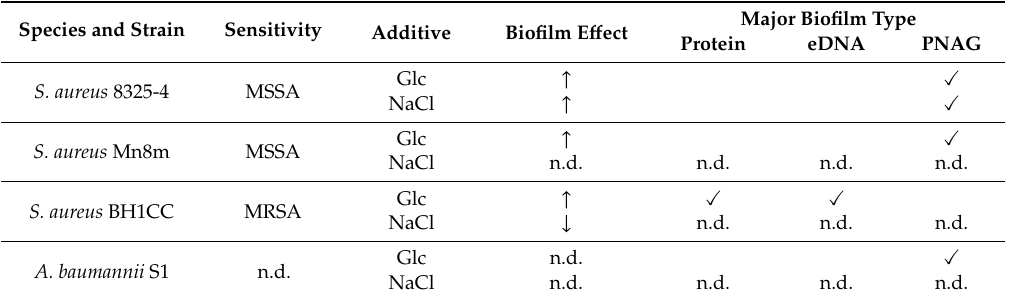
Table 1. Major biofilm types and e ff ects of glucose and NaCl on biofilm formation by selected bacterial strains. All reports for S. aureus are based on biofilm assays carried out on hydrophilic 96-well plates [9,25–27,29–31]. Reports for A. baumannii are based on biofilm formation on borosilicate